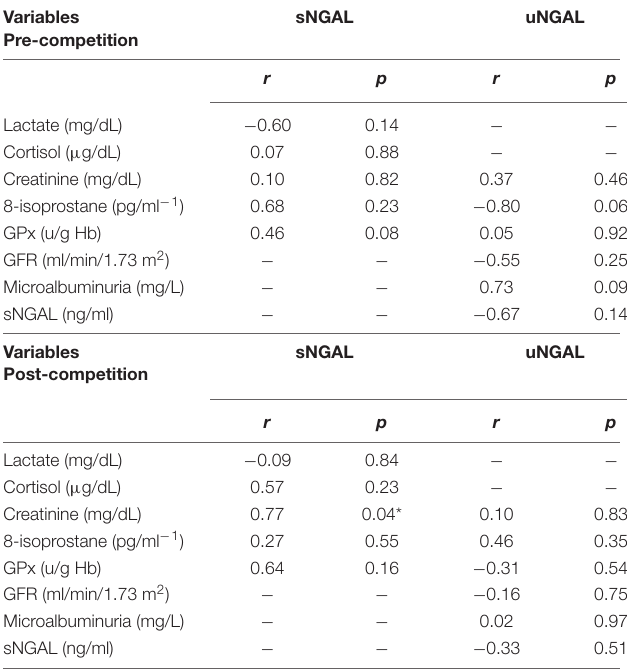
TABLE 5 | Correlation matrix between sNGAL and uNGAL with blood and urine biomarkers pre and post competition ( n = 7). Variables Pre-competition